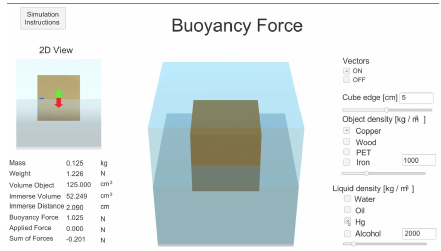
Figure 15. Buoyancy scenario.